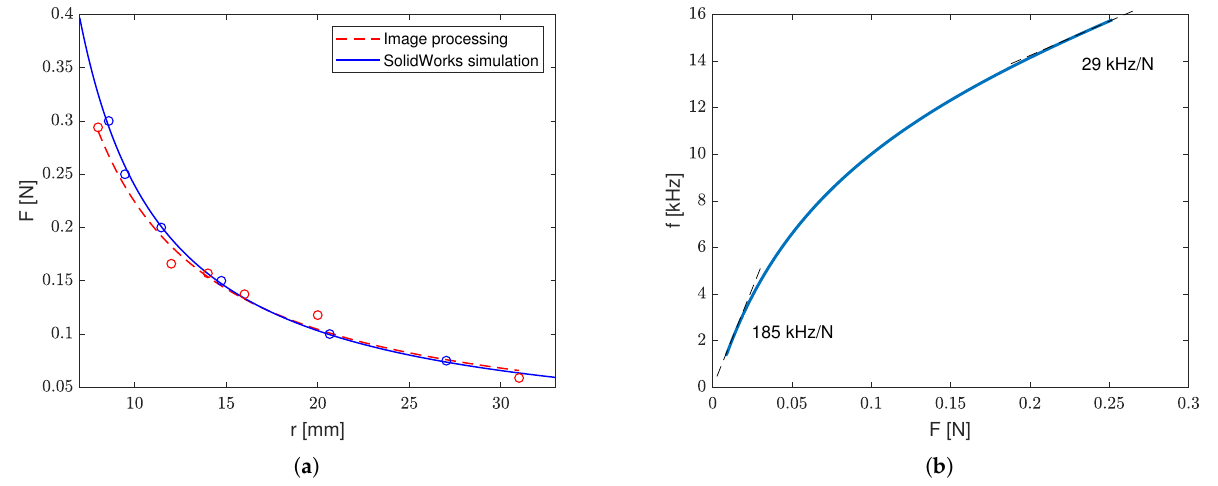
Figure 17. Sensor characterization results: ( a ) comparison of F ( r ) relationships obtained with Solid- Works and the physical measurements and ( b ) the output characteristic function of the